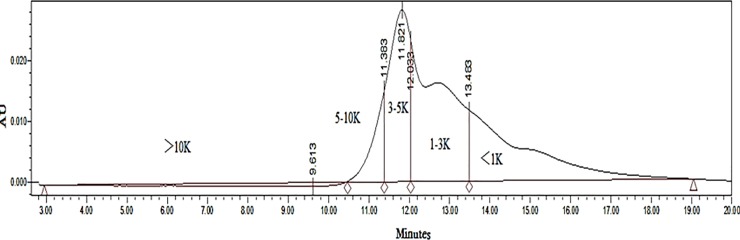
HPLC diagram for molecular weight distribution.